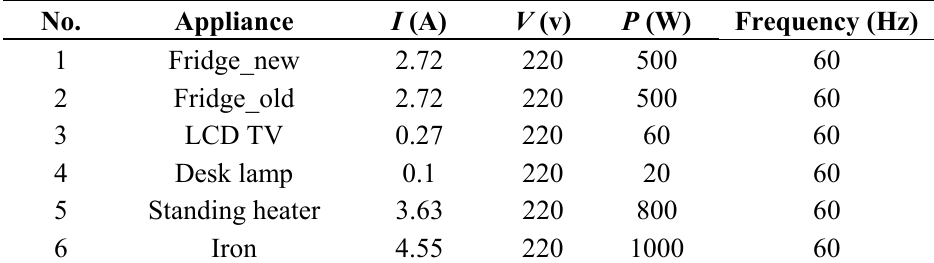
Table 2. Appliance power